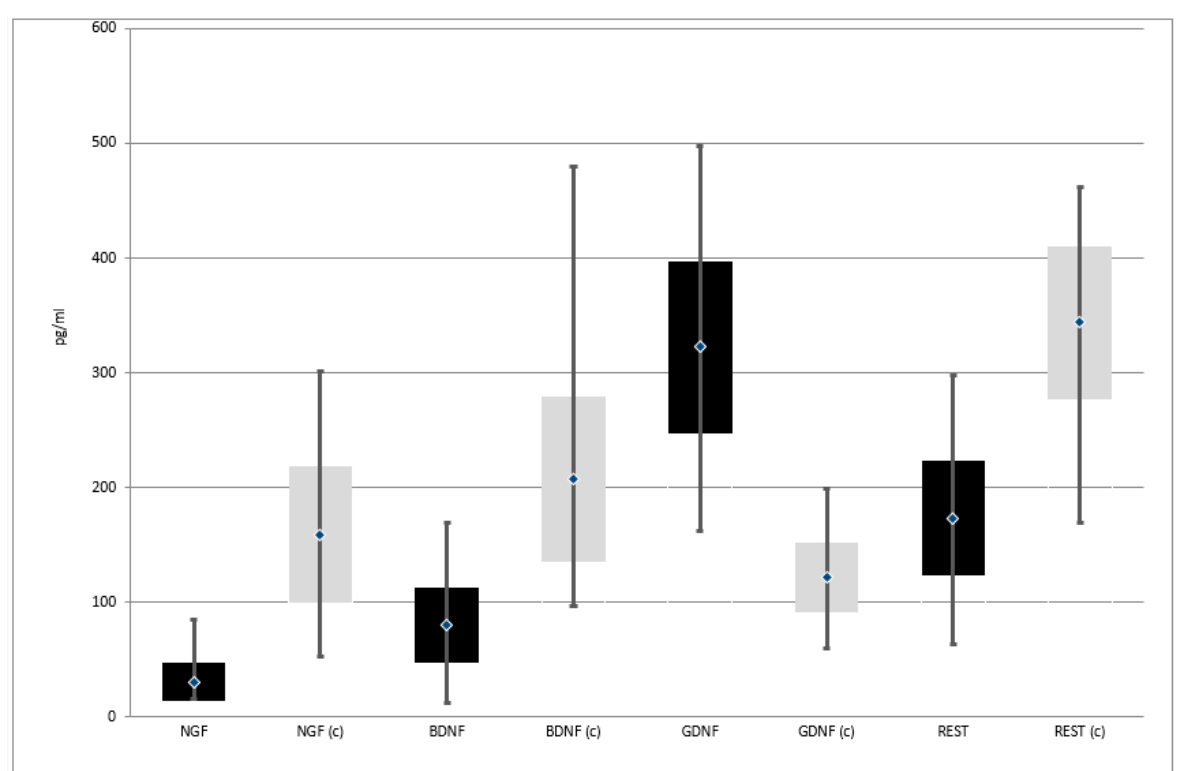
Figure 2. Expression of selected genes regulating the process of neurogenesis at mRNA level in the study and the control group; black—study group; light gray (c)—control group; NGF—Nerve Growth Factor; BDNF—Brain-Derived Neurotrophic Factor; GDNF—Glial-Derived Neurotrophic Factor; REST—RE1-Silencing Transcription factor.